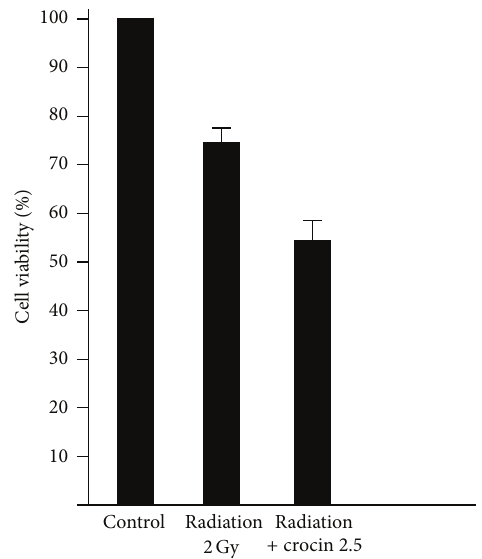
Figure 3: Survival rate of Mcf-7 cells with 2Gy radiation 24h and combination of 2 Gy radiation 24 h and crocin 2.5 mg/mL